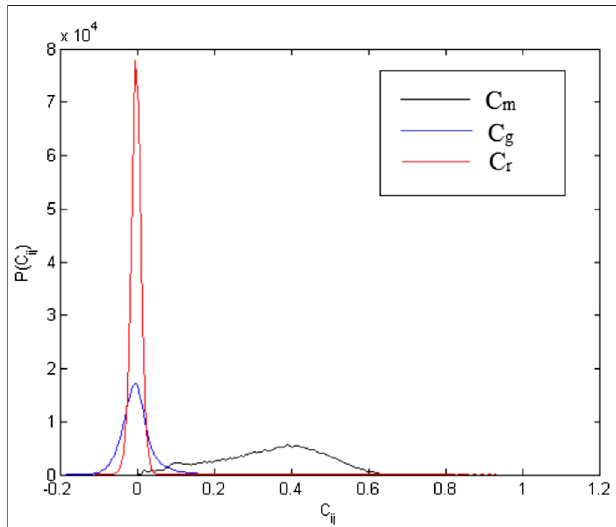
FIGURE 9 | Matrix decomposition shows successfully decompose the group into three different parts. Distribution of Cm (black), Cg (blue), and Cr (red) on the S&P 500 daily share price data for the period of January 1, 2007 until October 28, 2016. This indicates that the method successfully shows the decomposition and contribution from each